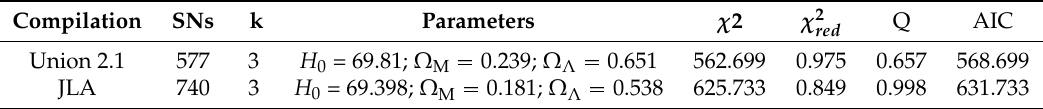
Table 1. Numerical values of χ 2 , χ 2 , Q , and the AIC of the Hubble diagram for two compilations; k red stands for the number of parameters. SN, supernoval; JLA, joint light-curve